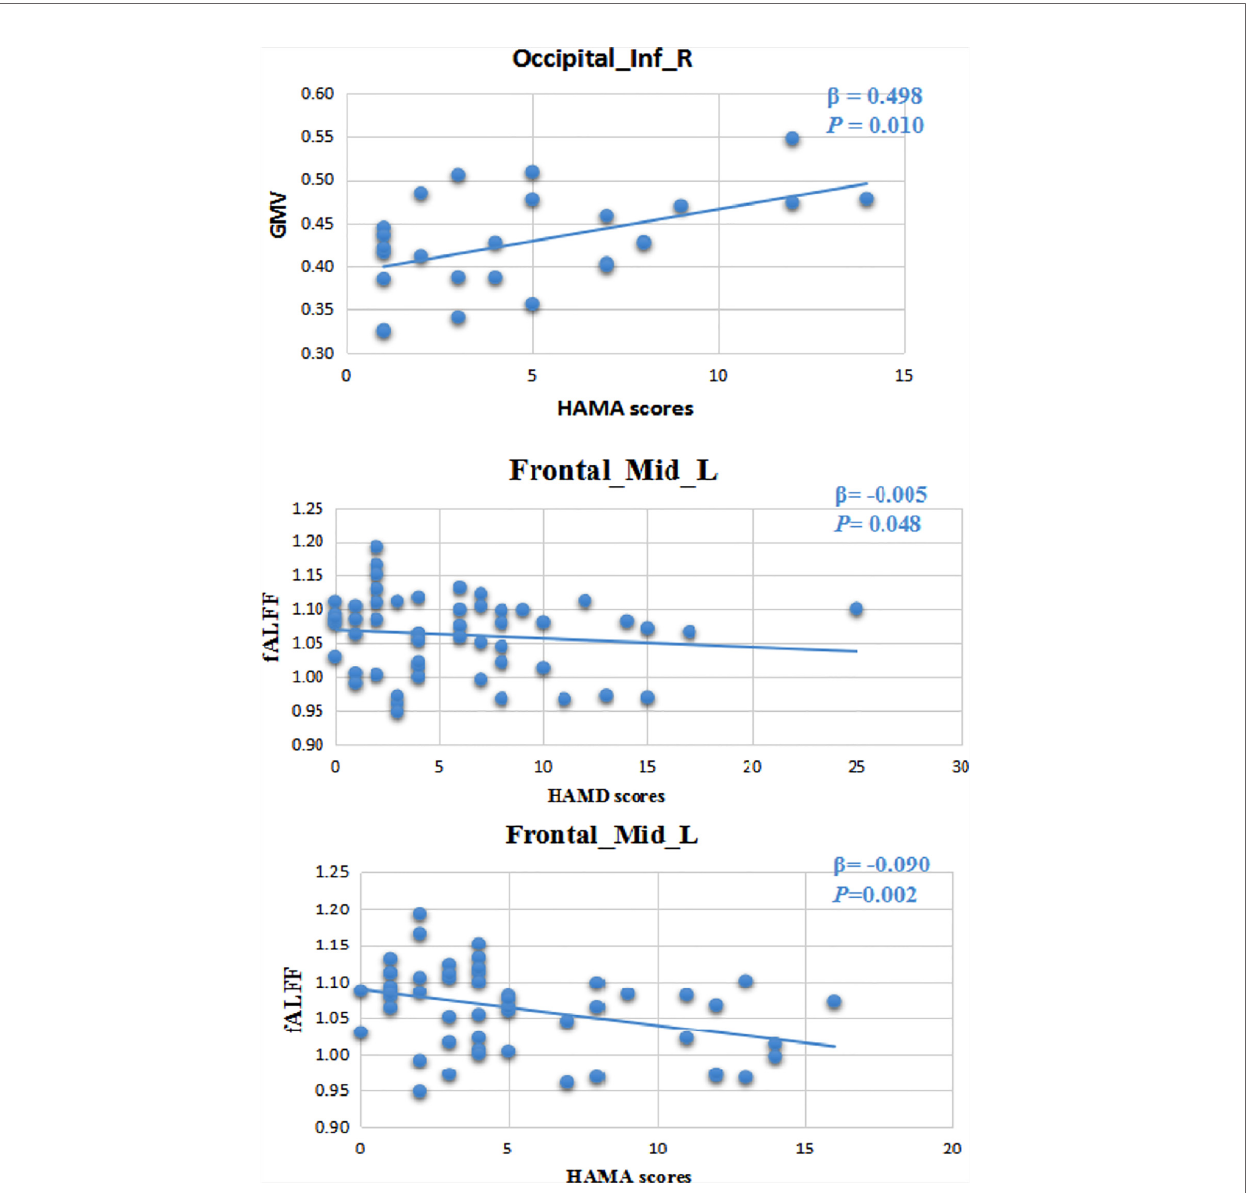
FIGURE 2 | Volume of gray matter in the inferior occipital cortex had a correlation with the HAMA scale ( b =0.498, P=0.010). There was a correlation between regional brain function activity (fALFF) in the left middle frontal gyrus and HAMA ( b =-0.090, P=0.002) and HAMD ( b =-0.005, P=0.048). 24-HAMD: Hamilton depression rating scale. 14-HAMA: Hamilton anxiety rating scale.